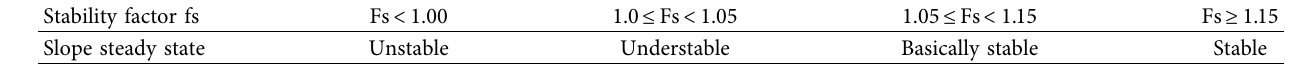
Table 1: Slope stability state grading table.